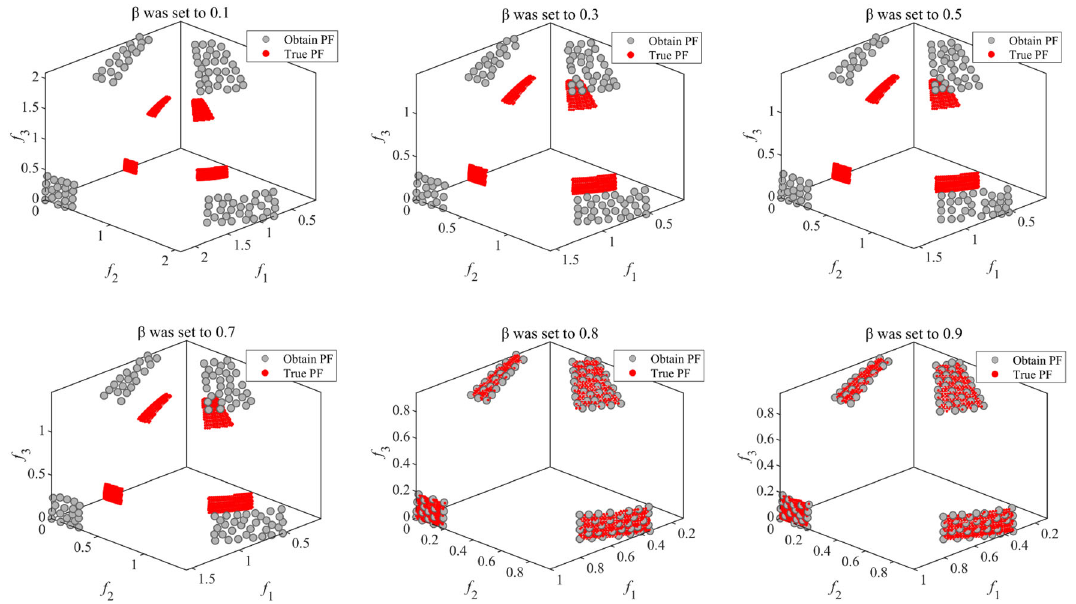
Fig. 7 Pareto fronts with median IGD value among 30 runs obtained by EGDCMO DC3-DTLZ3 corresponding to different values of β